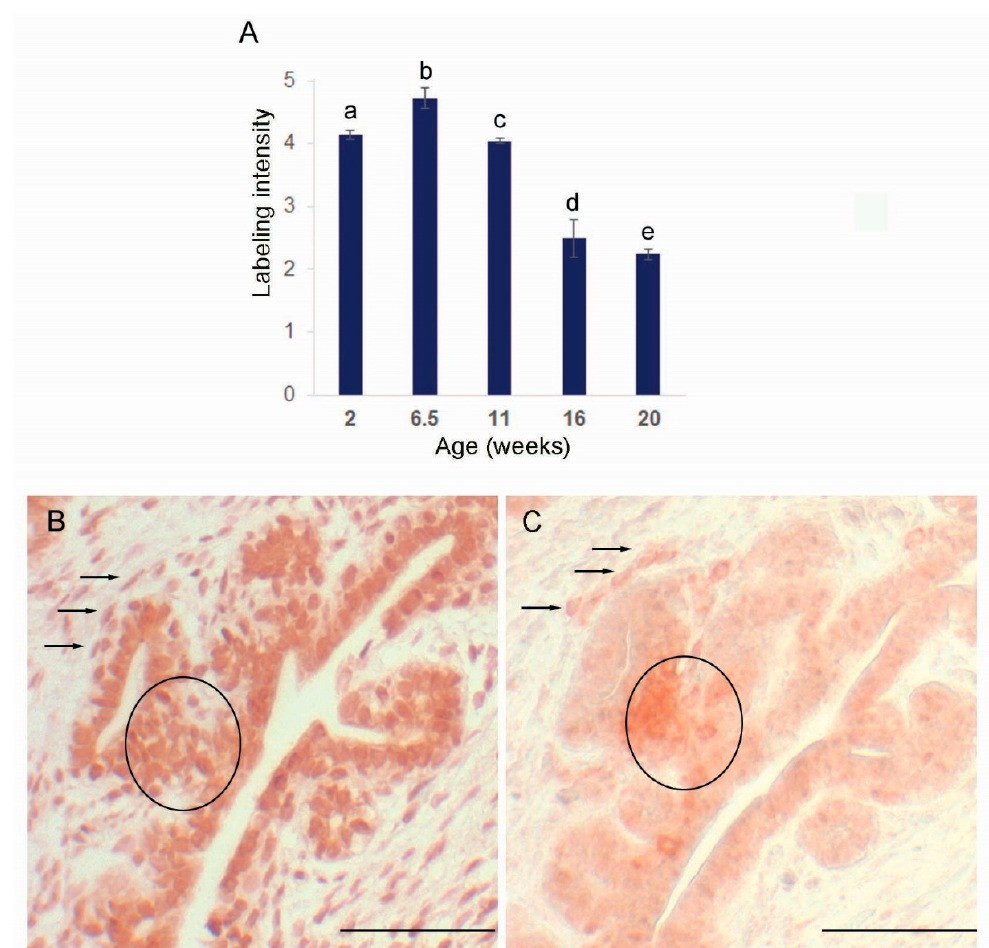
Figure 6. SRD5A2 protein in the porcine prostate. ( A ). Relative intensity of protein labeling in the prostate epithelium. Values represent means and SEM. Columns labeled a,b or b,c differ, p < 0.05. Columns labeled a,e; c,d; or c,e differ, p < 0.001. ( B , C ). Serial sections of prostate from a 6.5-week-old boar immunolabeled for SRD5A2 and for CD45, respectively. Circles and arrows point to a cluster of cells and individual cells, indicating that a minor portion of SRD5A2 expression colocalizes with leukocytes. Scale bar represents 50 μ m.